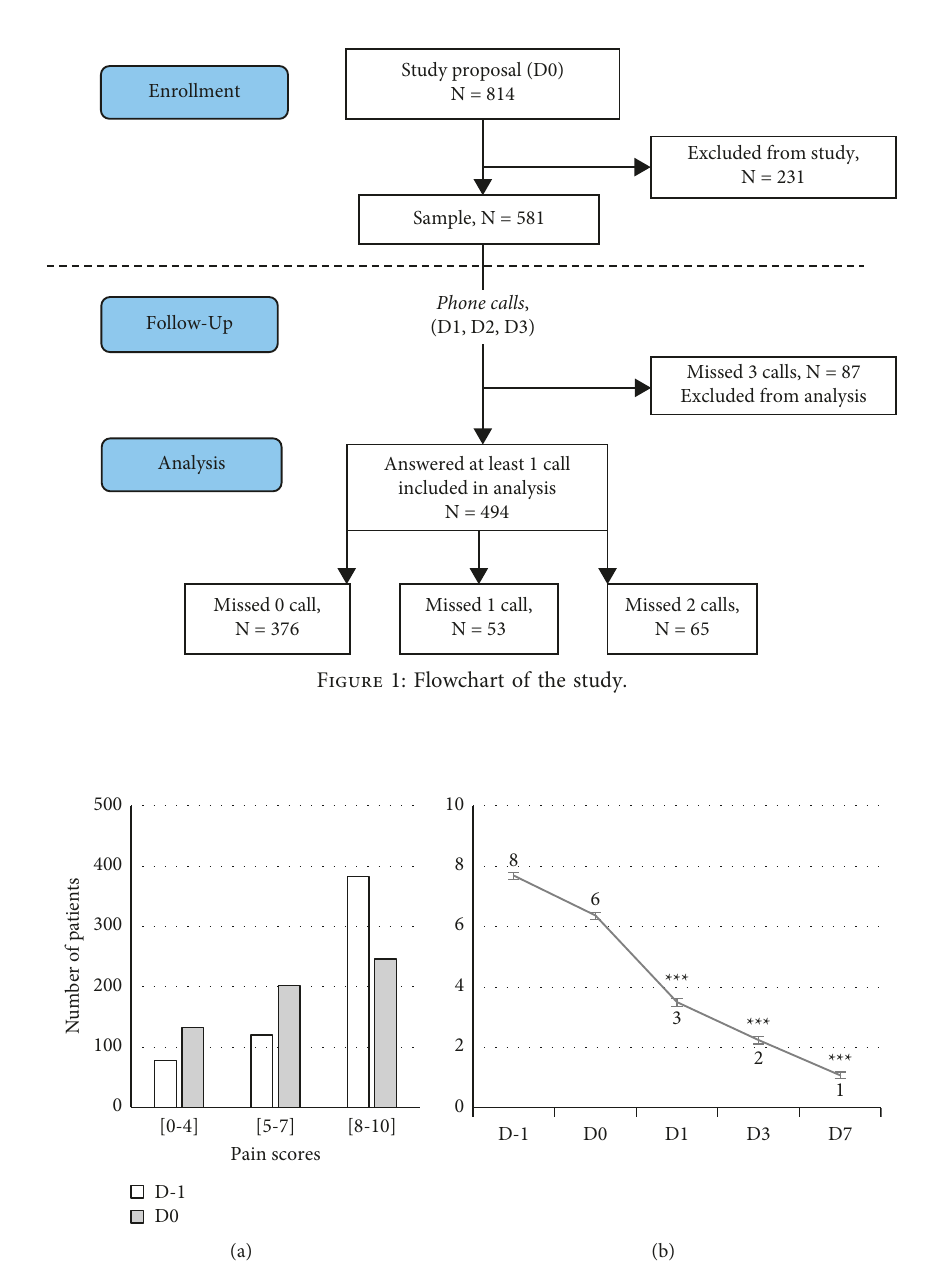
Figure 2: (a) Distribution and evolution of pain scores on D1 and D0 according to severity of the pain. (b) Evolution of pain scores (mean ± SEM) from D1 to D7 indicating a significant decrease between baseline (D0) and endpoints (D1, D3, D7) (ANOVA, Dunn’s test, p < 0 . 001). Pain scores were self-evaluated on a [0–10] numeric rating scale.